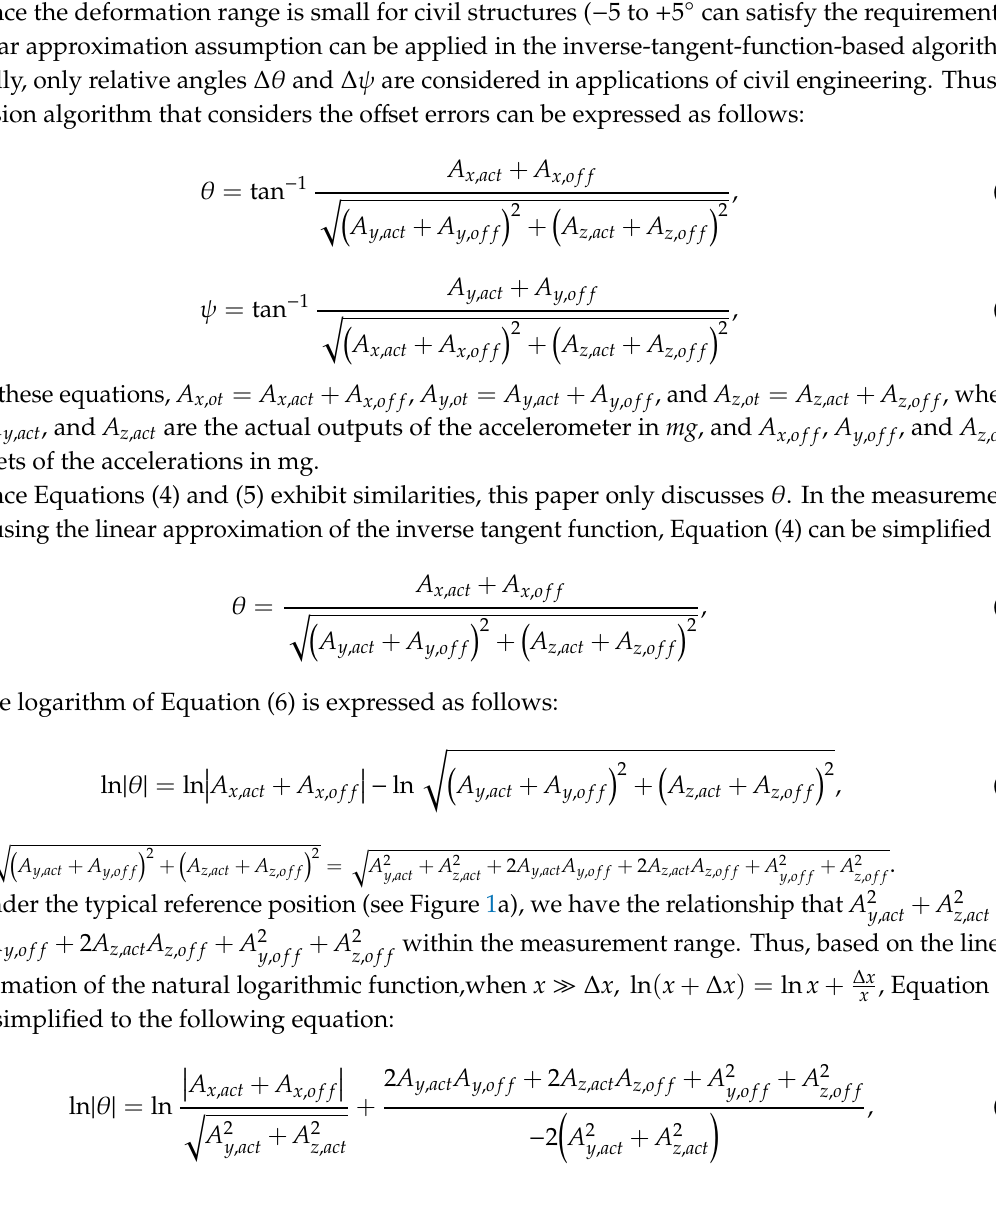
accelerometer; ( b ) the 2-axis MEMS accelerometer.